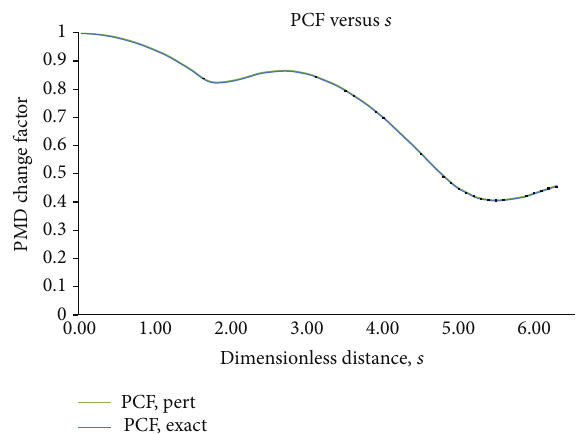
Figure 2: The PCF curves for a perturbative limit with Λ = 1 and 𝐿 𝐵 = 12